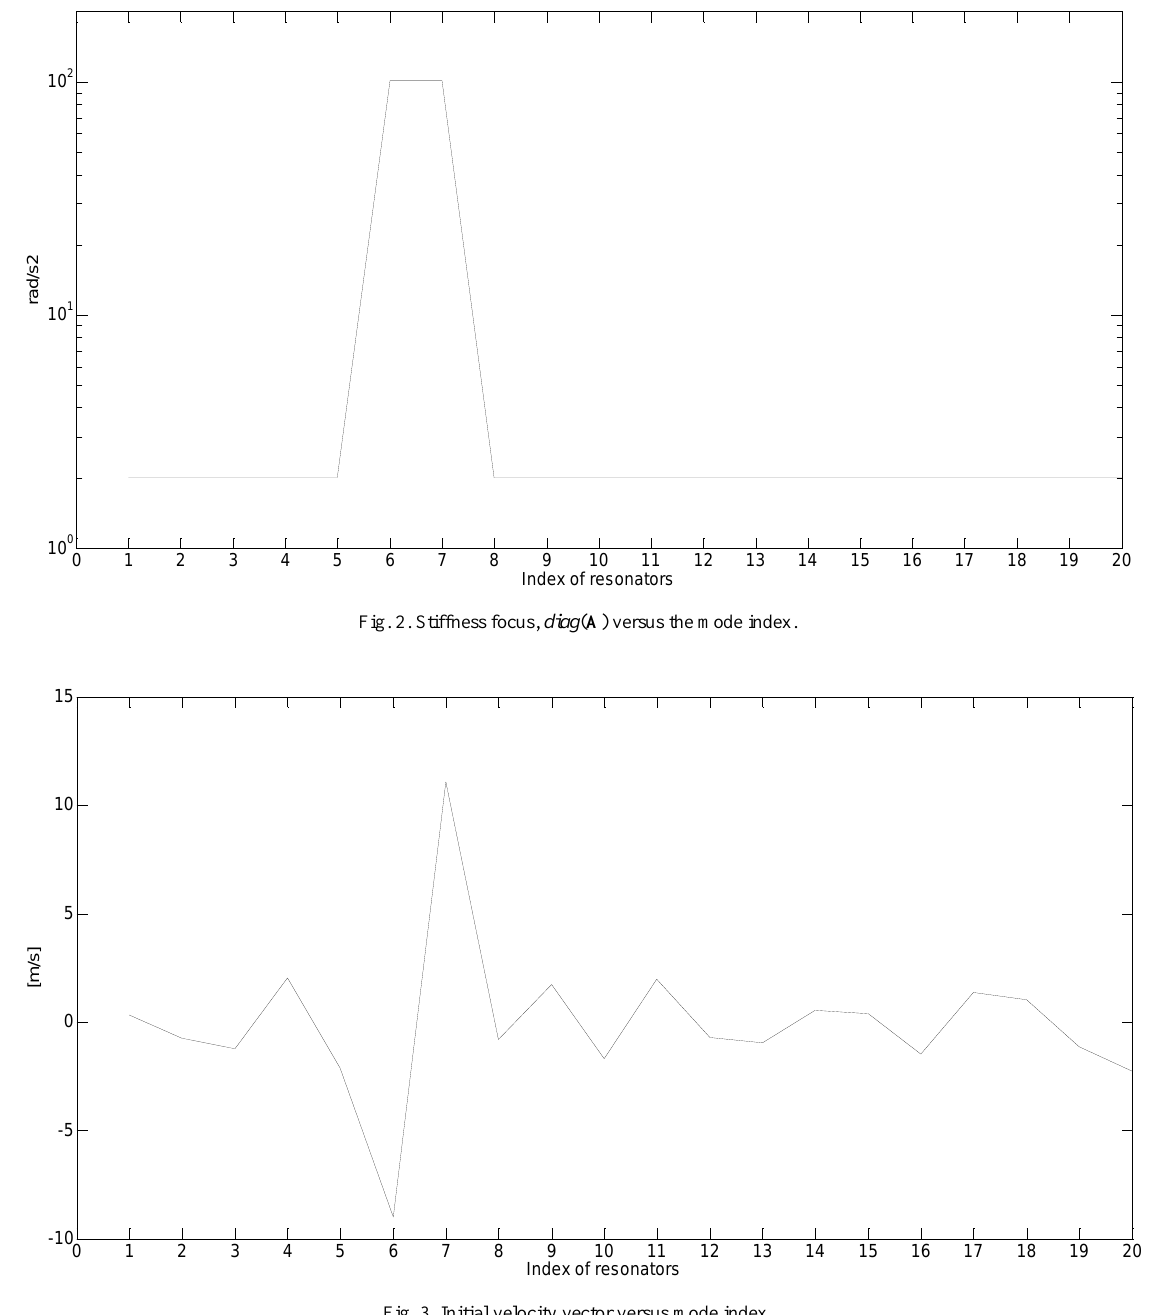
Fig. 3. Initial velocity vector versus mode